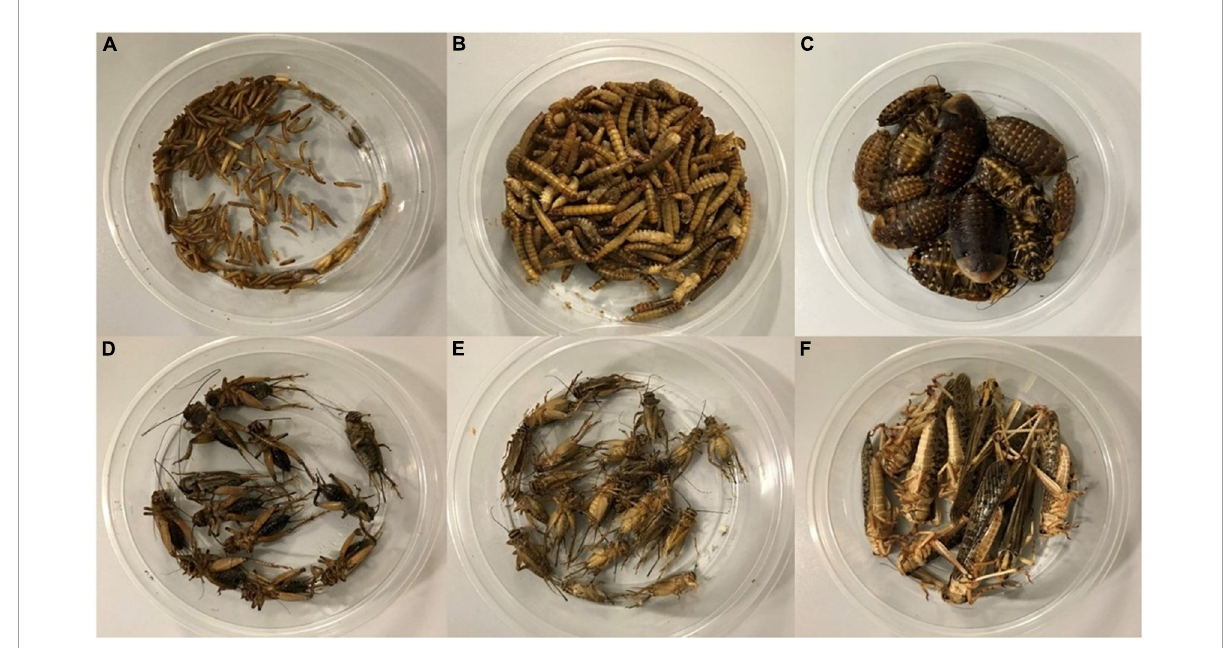
FIGURE1 Analyzed insect species A. diaperinus (A) , T. molitor (B) , B. discoidalis (C) , A. domesticus (D) , G. assimilis (E) , and L. migratoria (F) .